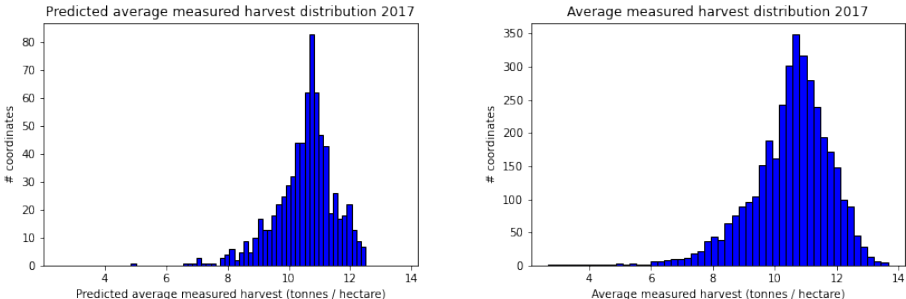
Figure 10. The predicted yield distribution for 2017 ( left ), obtained using an LGBM model with grid G-50 and input “All features”, closely matched the true yield distribution ( right ). The model accurately captured the shape, mean, and variance of the true distribution for this year.